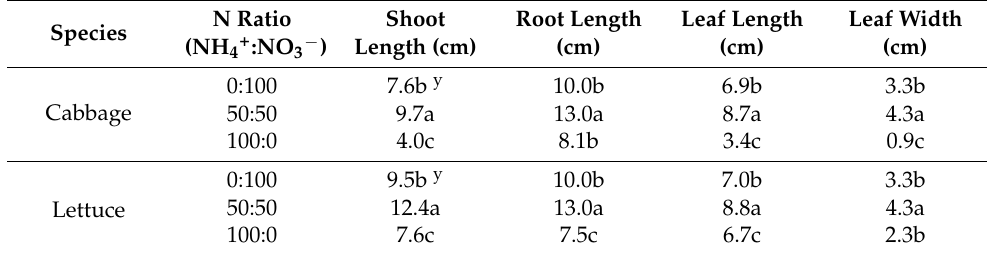
Table 2. Growth attributes of two vegetables treated with three NH 4+ :NO 3 −